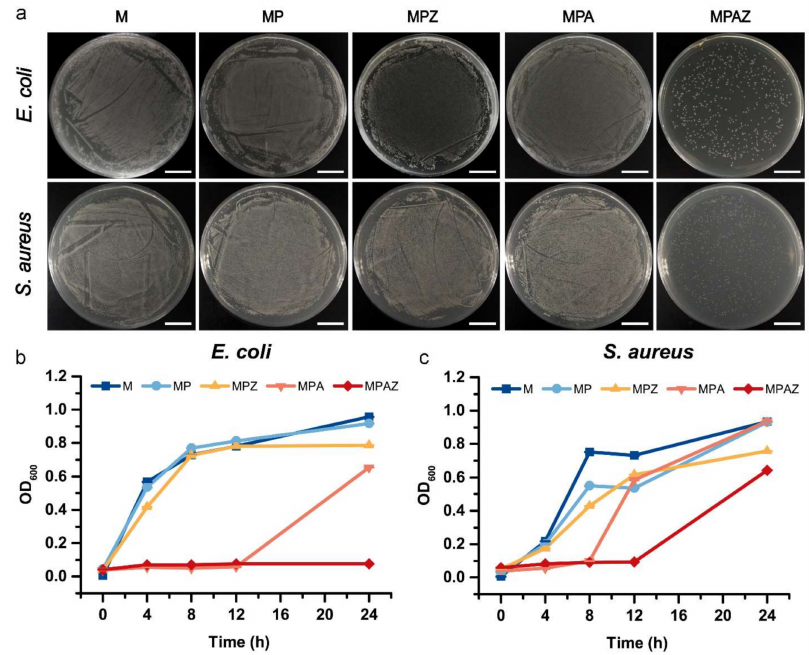
Figure 7. Colony counting and bacterial growth curve assays. ( a ), The colonies of E. coli and S. aureus after culture in the presence of different films for 24 h and 12 h, respectively; ( b , c ), bacterial growth curves in the presence of different films. Scale bar, 1 cm.